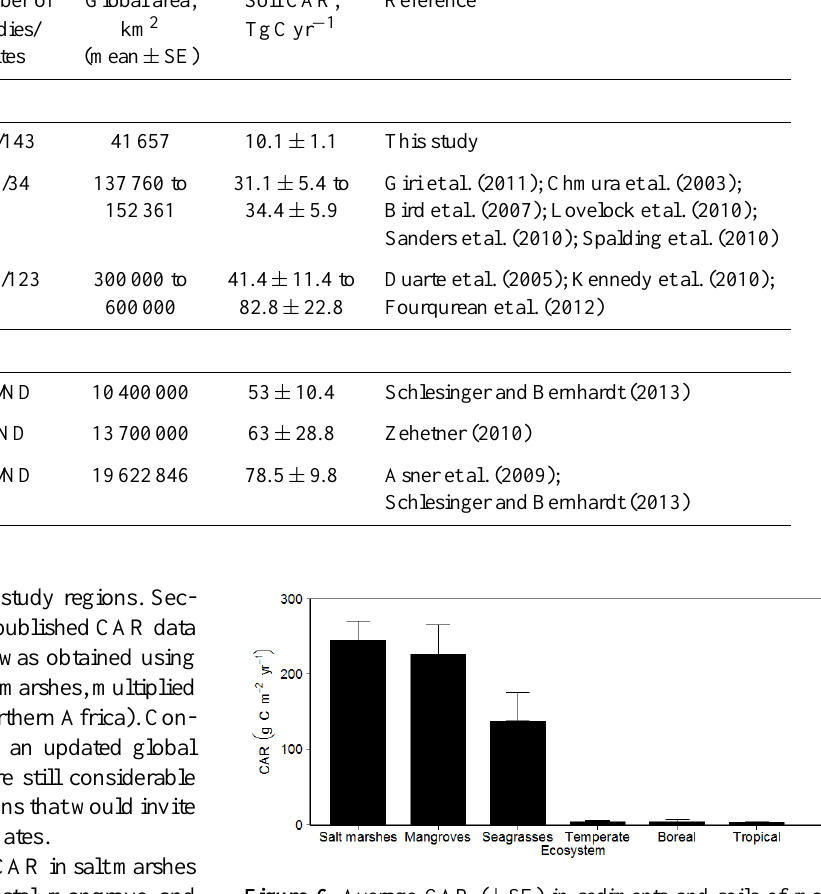
Figure 6. Average CAR ( ± SE) in sediments and soils of major coastal and terrestrial forest